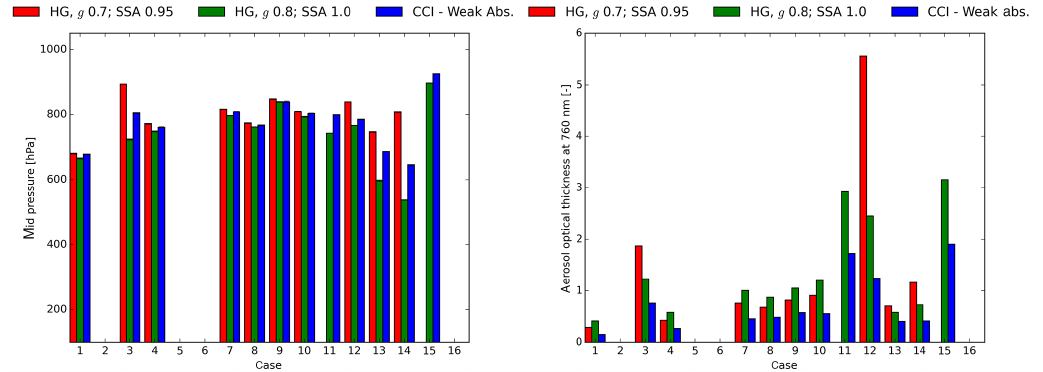
Figure 10. Retrieved aerosol layer mid pressure (left) and aerosol optical thickness (right) for 16 GOME-2A target pixels and three different aerosol models. Details are the same as in Fig. 9, except that now the surface albedo is fixed in retrieval (as in Fig.